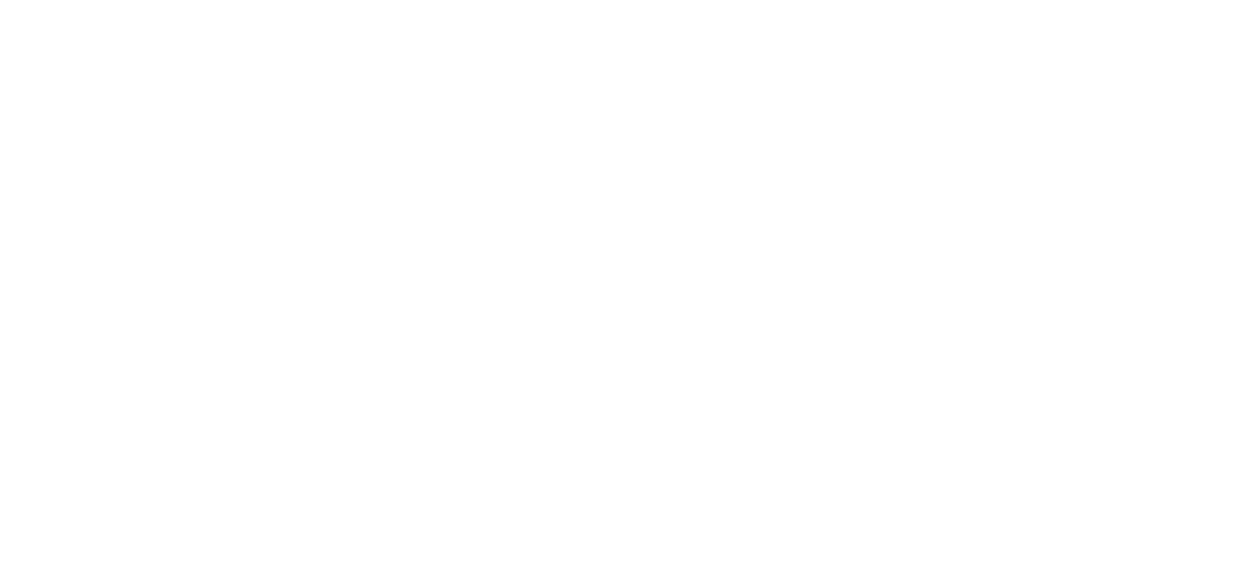
FIGURE A2 | Correlations among fluency, speed, trace length, and